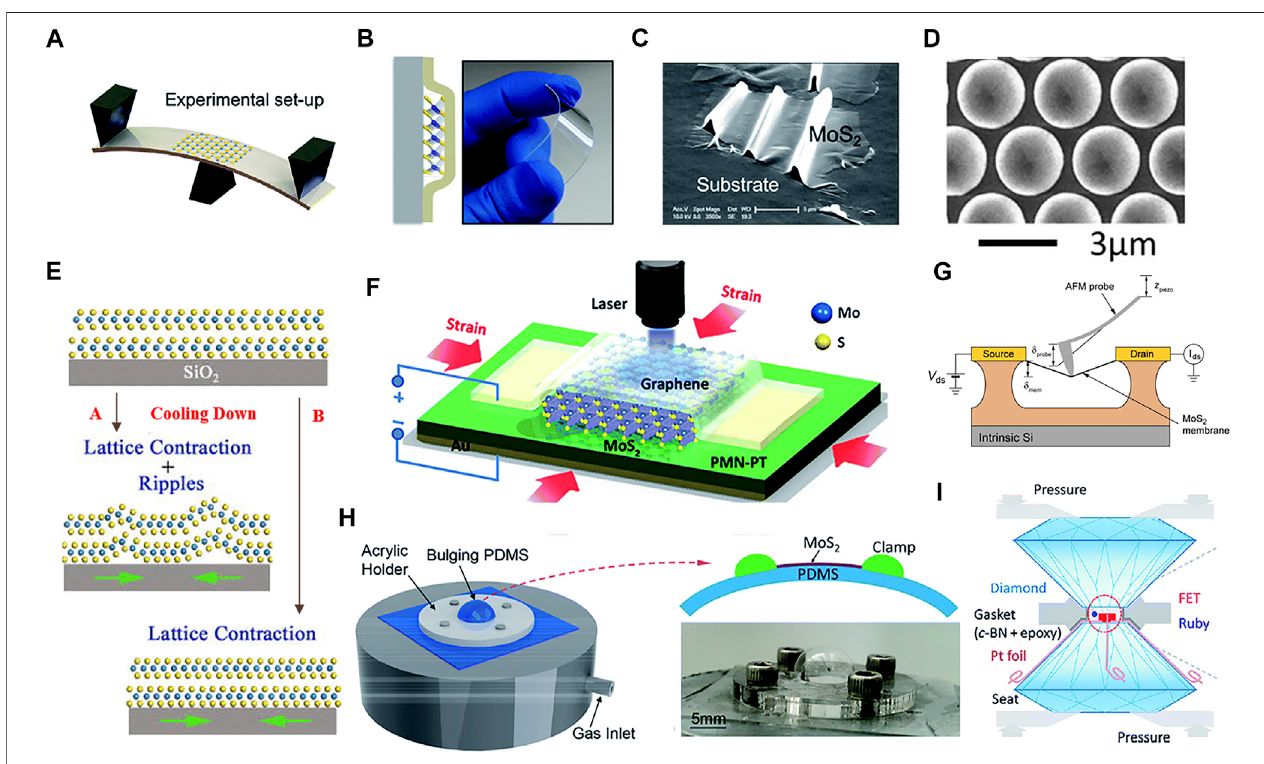
FIGURE4| Theschematicdiagramofapproachesforintroducingexternalstrain. (A) Thethree-pointbendingapparatus.ReprintedwithpermissionfromRef.[74], Copyright2013, American Physical Society. (B) Large strain magnitude canbe introducedinpolymerencapsulated mono-layer WSe 2 bybendingapparatus.Reprinted with permission from Ref. [75], Copyright 2018, American Chemical Society. (C) Wrinkled mono-layer MoS 2 fabricated by prestretching an elastomeric substrate. Reprinted with permission from Ref. [76], Copyright 2013, American Chemical Society. (D) The top-view scanning electron microscopy (SEM) image of the patterned sapphire substrate (PSS). Reprinted with permission from Ref. [77], Copyright 2019, American Chemical Society. (E) Schematic diagrams showing the mismatch of thermal expansion coef fi cient on the formation of strain in WS 2 fl akes. During cooling process, the SiO 2 substrate contracts and exerts compression stress on theWS 2 fl akes. Reprintedwithpermission fromRef.[78],Copyright2016,American Institute ofPhysics. (F) Schematicdiagramofoptical measurementsonstrained trilayer MoS 2 which is sandwiched between a piezoelectric substrate and a graphene electrode. Reprinted with permission from Ref. [79], Copyright 2013, American Chemical Society. (G) SEM image of typical MoS 2 devices with suspended channels and contact electrodes. Reprinted with permission from Ref. [81], Copyright 2015, American Chemical Society. (H) Experimental setup for blown-bubble bulge measurement, high strain can be achieved in suspended MoS 2 fi lms by slowly diffusing N 2 gas through the PDMS substrate to pressurize the cavity. Reprinted with permission from Ref. [80], Copyright 2017, American Chemical Society. (I) Schematic of the